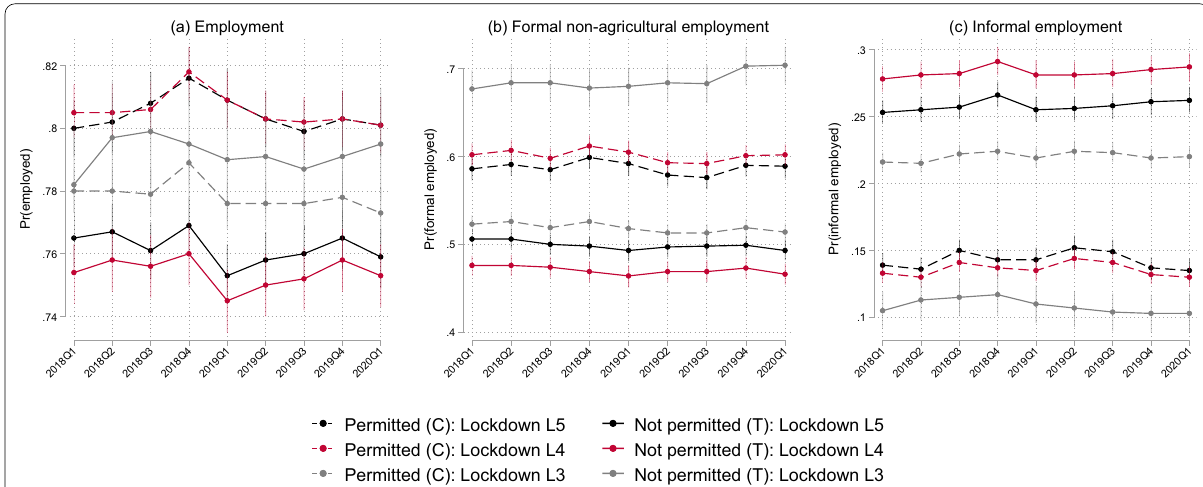
Fig. 2 Pre-treatment outcome dynamics, by outcome and lockdown stringency level. Author’s own calculations. Source : QLFS 2018Q1–2020Q1 (Statistics South Africa 2018a, b, c, d, 2019a, b, c, d, 2020b). Notes : This figure presents estimates of trends in mean outcome levels for the treatment (T) (not permitted to work) and control (C) (permitted to work) groups in the pre-treatment period by making use of cross-sectional data from 2018 to 2020. Estimates are presented for each lockdown stringency level which range from level 5 (L5) (most stringent) to L3 (most lenient). Sample restricted to the working-age population (15–64 years). All estimates are weighted using the sampling weights and account for the complex survey design. Spikes represent 95% confidence